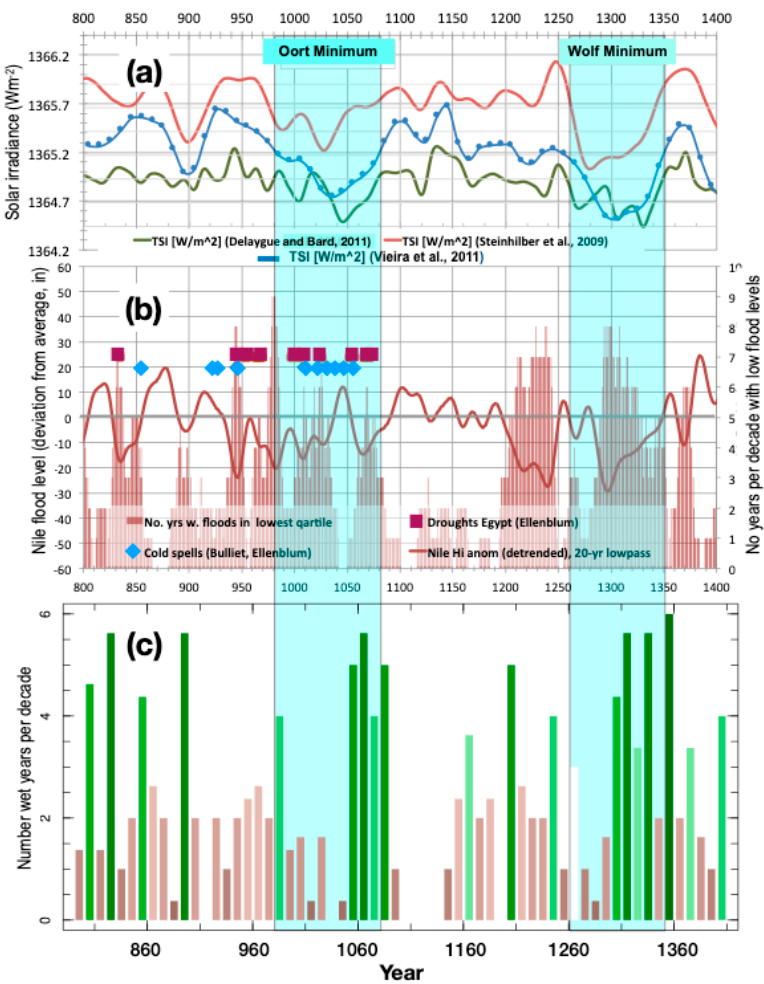
Figure 5. ( a ) Solar irradiance variations during the last millennium and a half. Shown are two estimates of total solar irradiance (TSI, scale in W m − 2 on the left) based on 10 Be concentration in ice cores according to [63] (in red) and [64] (in green). The blue line is the smoothed, reconstructed number of sunspots, based on 14 C from tree rings according to [65] (scale on right). The times of the Oort and Wolf Grand Minima are indicated by blue vertical stripes. ( b ) The Nile flood record (solid line), smoothed to retain fluctuations with a period of 20 years and longer and the number of years in an 11-year window with flood levels in the lowest quartile of the distribution of annual levels recorded between A.D. 641 and A.D. 1470 (vertical bars). Also shown are years when period chronicles indicate droughts in Egypt according to [28] (brown squares) and in the years of cold winters in Iraq and Iran according to [29] and [28] (blue diamonds). ( c ) The number of wet years in a decade, in an area bounded by 22.5 ◦ N and 37.5 ◦ N and 125 ◦ W and 97.5 ◦ W, in Southwest US and northern Mexico, where El Niño has a marked influence on precipitation. The analysis is based on the North American Drought Atlas (NADA, [66]) gridded Palmer Drought Severity (PDSI) values (positive value indicates wet and negative is dry). Wet years are years with an area-averaged PDSI value > 1. The average PDSI value in the area indicated, varies between − 2 and 2.